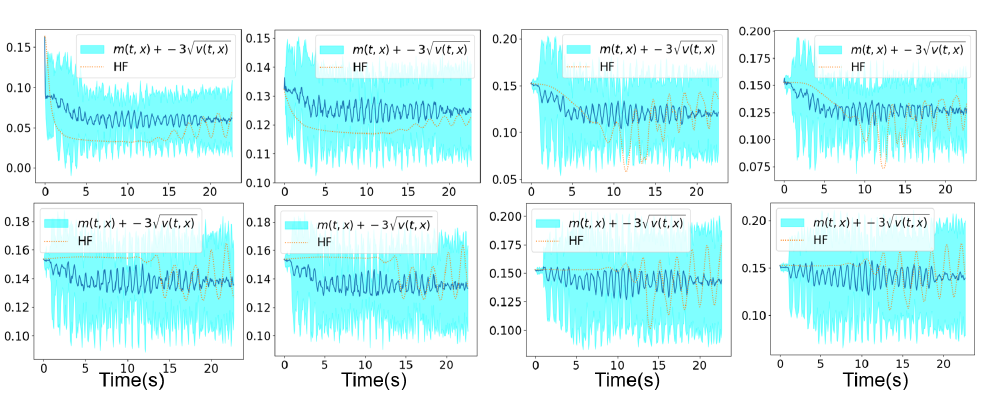
Figure 9. mesh n°1: High-fidelity Yales2 horizontal velocity projected on the Cartesian mesh in brown and the horizontal component of the mean prediction of the Bayesian ROM in dark blue, at six different spatial locations. The training data correspond to 15 s simulation time starting from 0 s. An extrapolation is performed from 15 s until 22.64 s. The clear blue zones are the ones contained in three standard deviations around the mean prediction of the ROM denoted m ( t , x ) . The mean prediction is obtained using an aggregation of 5 samples of the Navier–Stokes solution by the Bayesian nonlinear ROM.